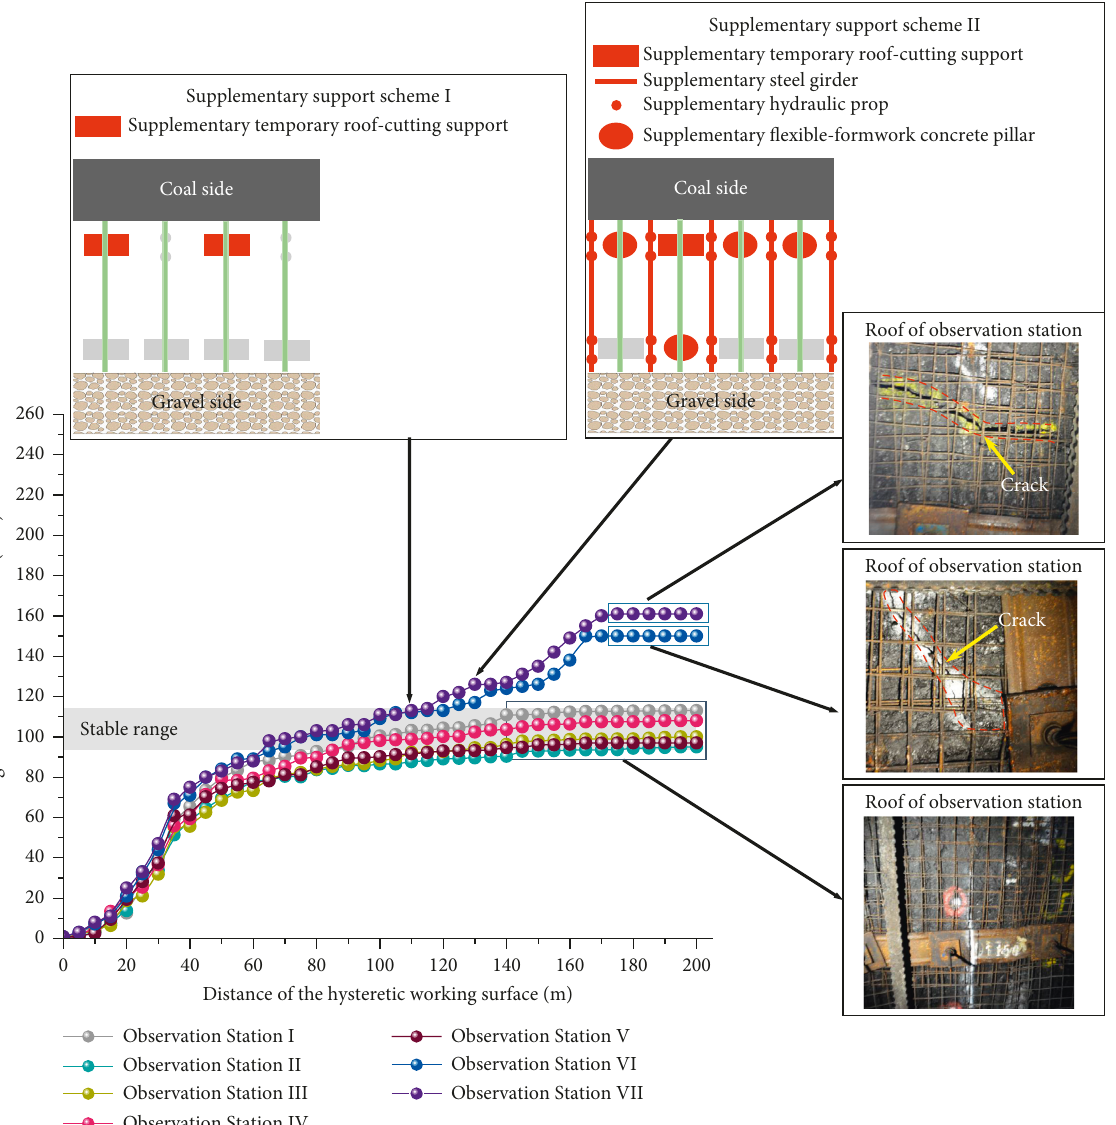
Figure 12: Relationship between roof and floor convergence in the center of the roadway and the distance of the hysteretic working